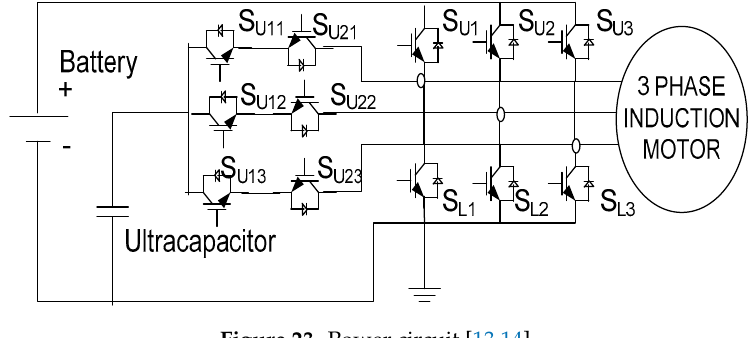
Figure 23. Power circuit [13,14].